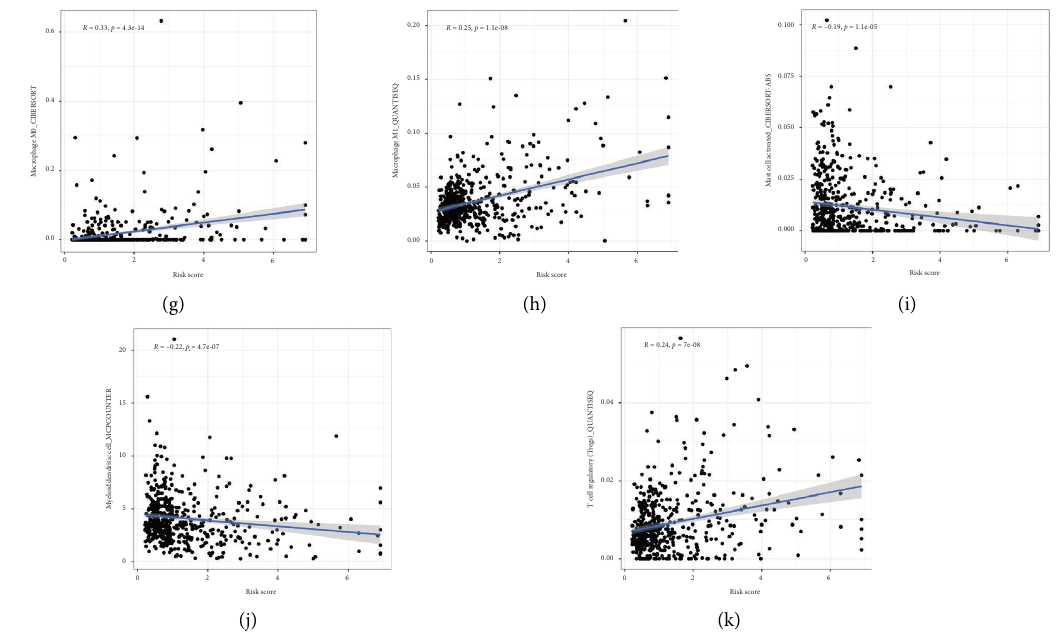
Figure 5: (a) Te correlation between the risk score and the immune score, including na¨ıve B cell (b); cancer-associated fbroblast (c); endothelial cell (d); hematopoietic cell (e); immune score (f); M 0 macrophage (g); M 1 macrophage (h); activated mast cell (i); myeloid dendritic cell (j); regulatory T cell